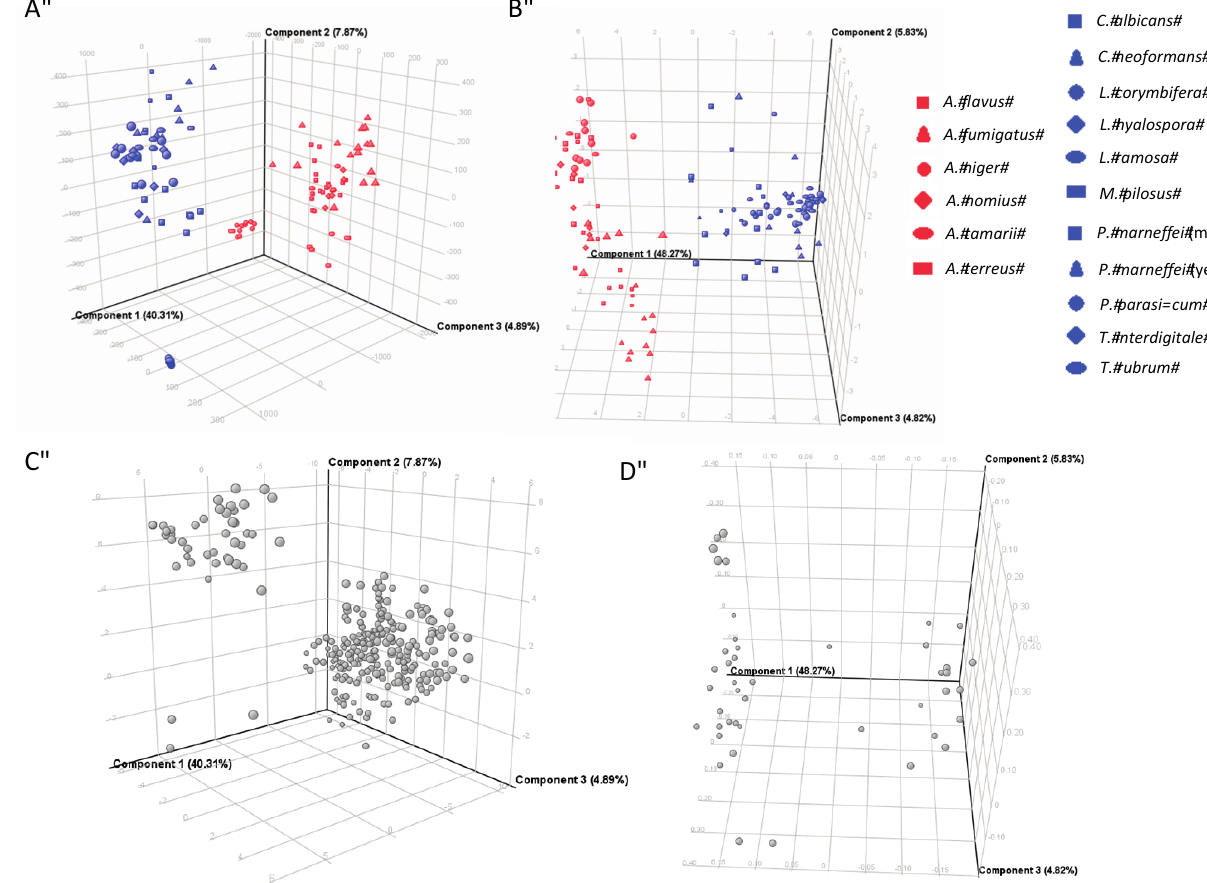
Figure 2. PCA score plots and PCA loading plots of 128 fungal culture supernatant samples. PCA score plots for ( A ) positive ionization mode data and ( B ) negative ionization mode data; PCA loading plots of molecular features for ( C ) positive ionization mode data and ( D ) negative ionization mode